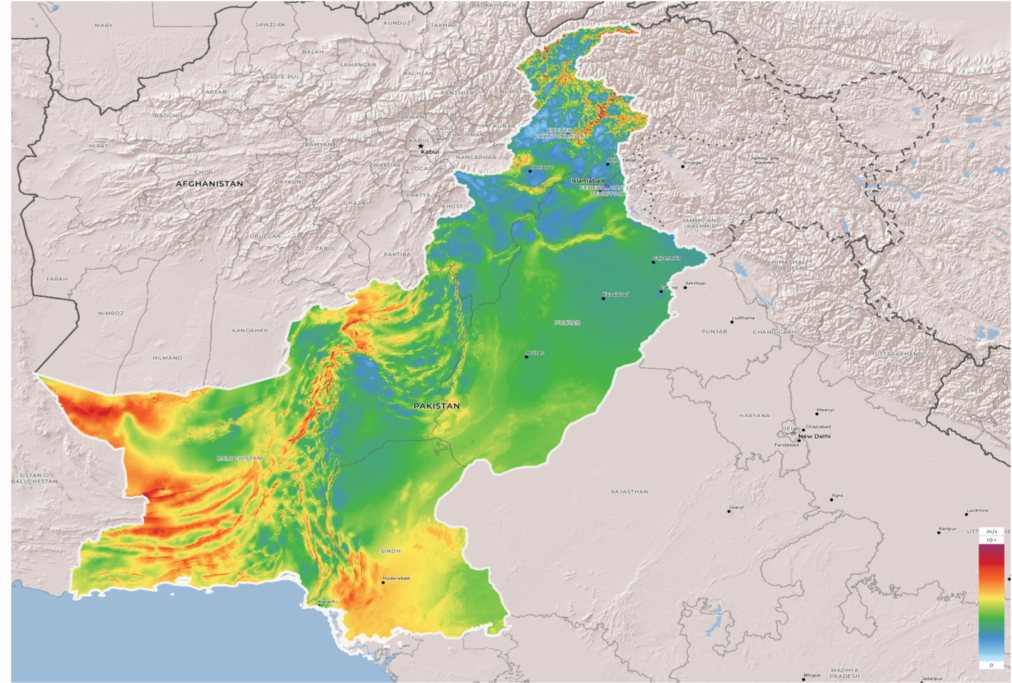
Figure 9. Wind speed map of Pakistan